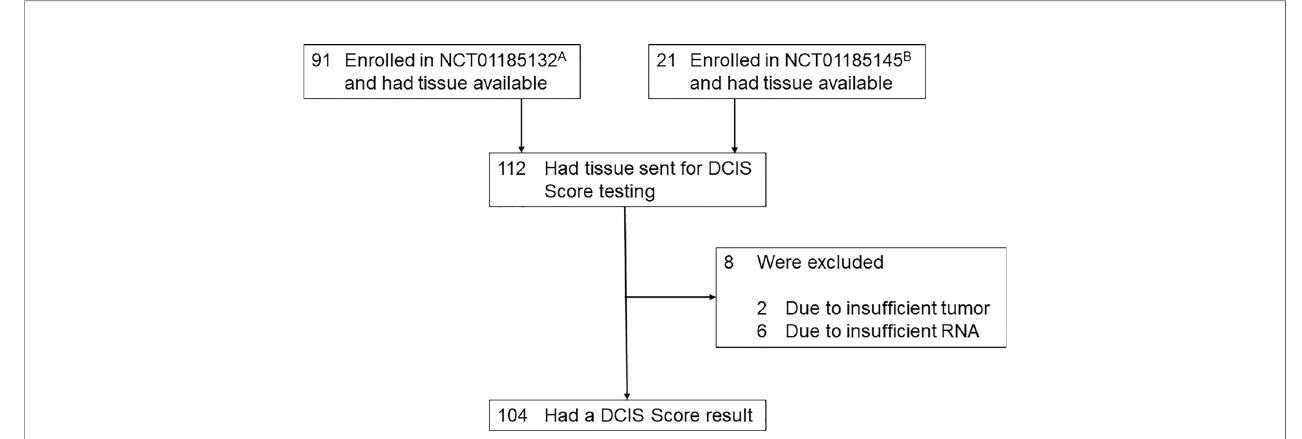
FIGURE 1 | Study fl ow diagram (N=104). (A) A Phase III Randomized Study Comparing Intensity Modulated Planning Versus 3-Dimensional Planning for Accelerated Partial Breast Radiotherapy (2009-APBI); NCT01185132; WIRB #20091193. (B) A Phase II Accelerated Partial Breast Radiotherapy With Either Mammosite or Intensity Modulated Radiotherapy (APBI); NCT01185145; WIRB